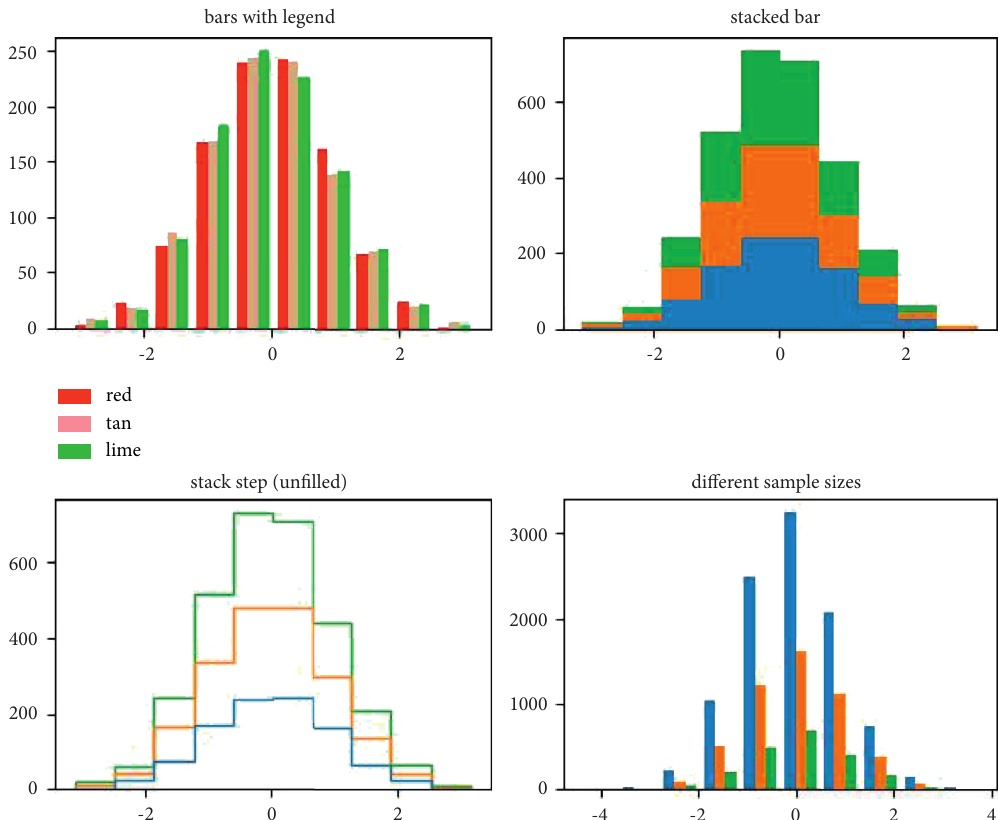
Figure 5: Distribution frequency histogram. (a) Bar with legends. (b) Stacked bar. (c) Stack step (unfilled). (d) Different sample